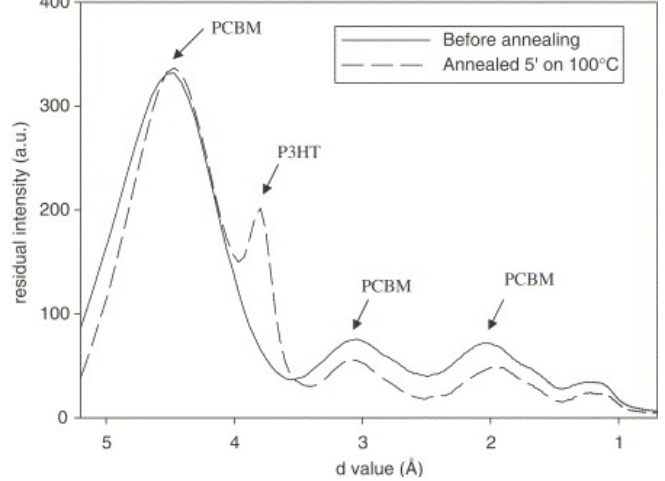
Figure 11. TEM diffraction patterns of P3HT:PCBM 1:2 blend before and after annealing. Reprinted with permission from Elsevier